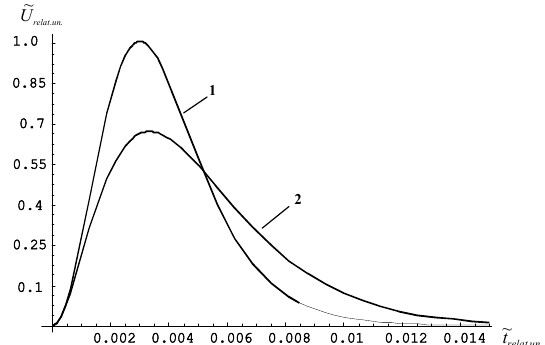
Fig 3. Dependencies of change of resulting shift in relative units: 1 - calculations according to expression (26), if k =0,4; 2 — calculations according to expression (27), if k =0. For both ~ graphs a =40, b =15 is accepted. U — rationed value on .. unrelat ~ U . t — rationed value on constt = max .. unrelat max area of the heterogeneity (local tension) corresponds to the dependence of change in the external tension